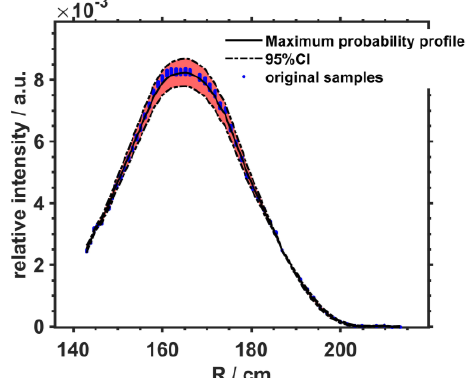
Fig. 7. Bayesian inference result of the magnetic field difference method on HL-2A. (the solid line is the relative T e of maximum probability, and the area between the dash lines is a 95% confidence